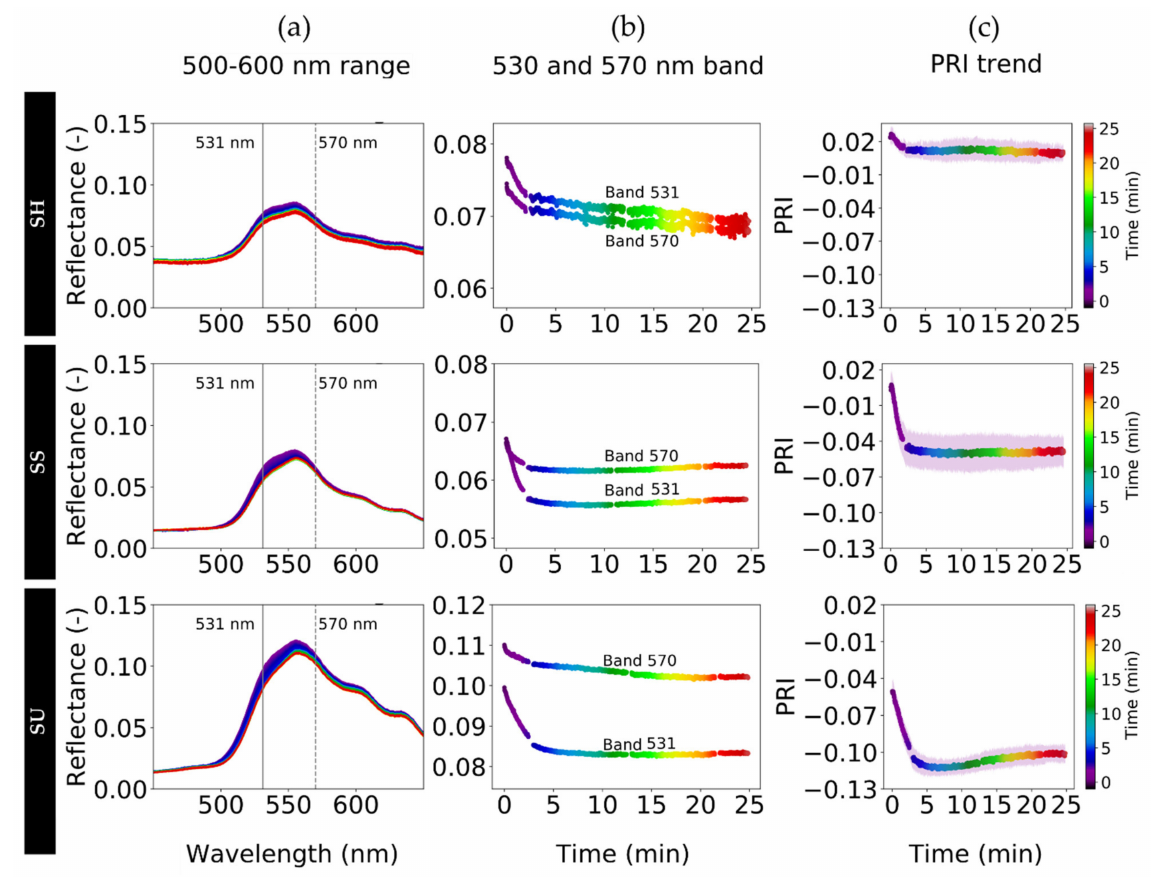
Figure 11. Canopy level temporal acquisitions of reflected light with the hyperspectral imager recording a single-pixel line (locked on the same position without scanning) of the dark-adapted SH, SS and SU canopies suddenly exposed to a saturating light intensity of 1200–1500 µ mol m − 2 s − 1 . ( a ) Column graphs: the average reflectance obtained from five selected canopy pixels of the line-image from the scanner locked on the same position for 20 min of the light exposure. ( b ) Column graphs: the transient for the PRI bands extracted from the reflectance spectrum. ( c ) Column graphs: the PRI index calculated for the 20 min illumination (purple shade represents a double-sided standard deviation calculated from five